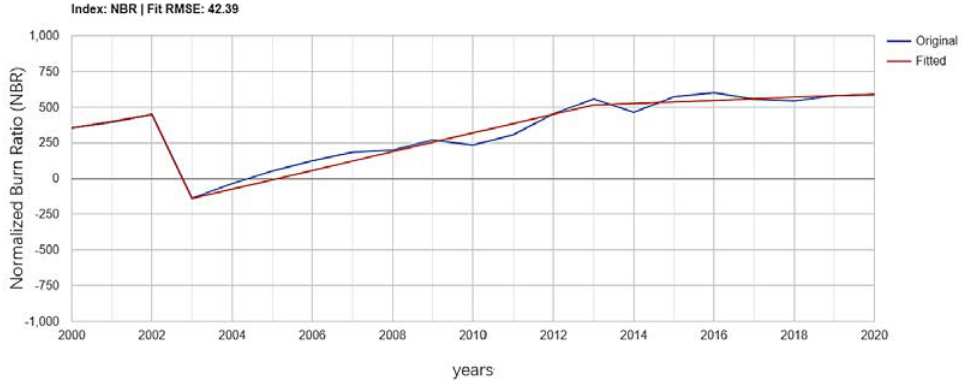
Figure 13. Normalized Burn Ratio (NBR) index trend from 2000 to 2020, in typical disturbance area.